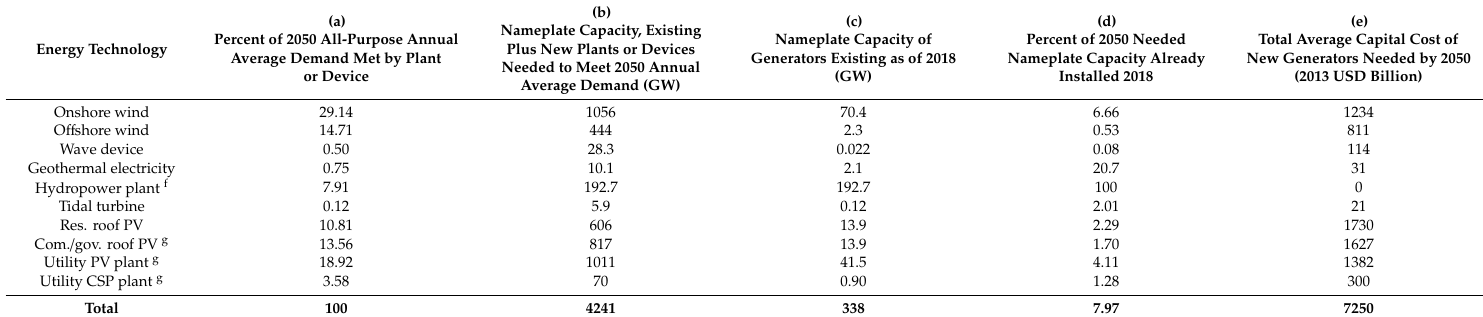
Table 2. ( a ) Percent of 2050 all-purpose end-use load met by each energy generator, averaged among all metropolitan areas. ( b ) Estimated nameplate capacities